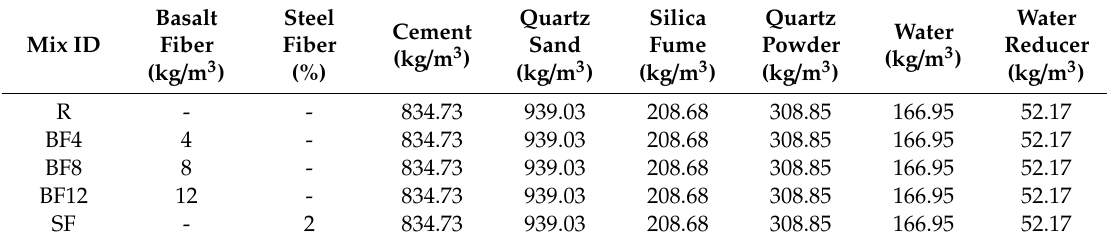
Table 5. The mixture proportion of basalt fiber reactive powder concrete (BFRPC) and steel fiber reactive powder concrete (SFRPC).